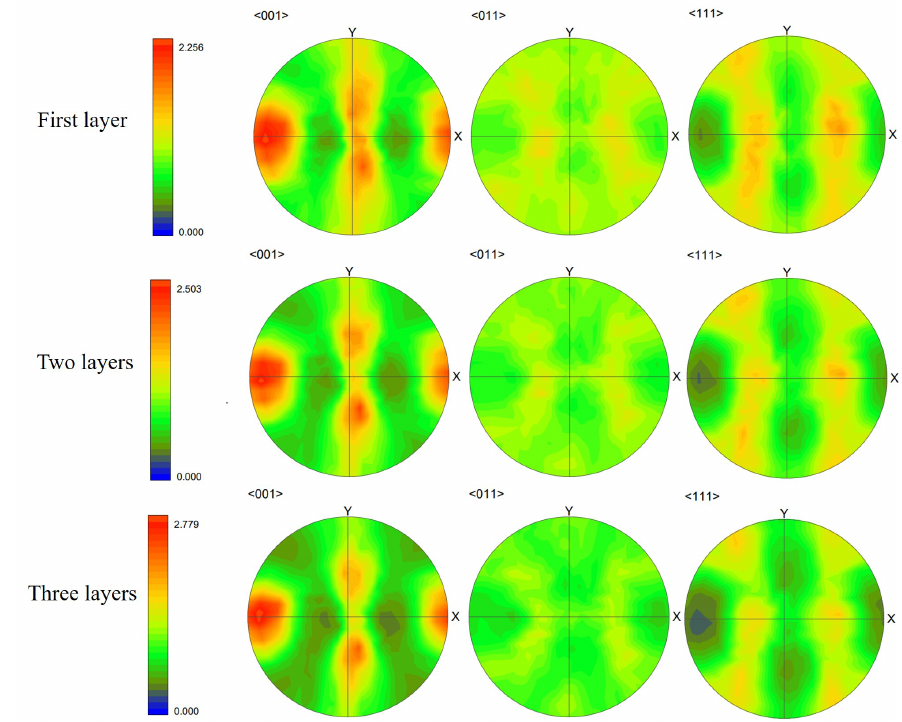
Figure 18. Pole figures (PF) of solidification grain structure within the fusion zone of the simulation results of first-layer, first two layers, and three-layer microstructure.